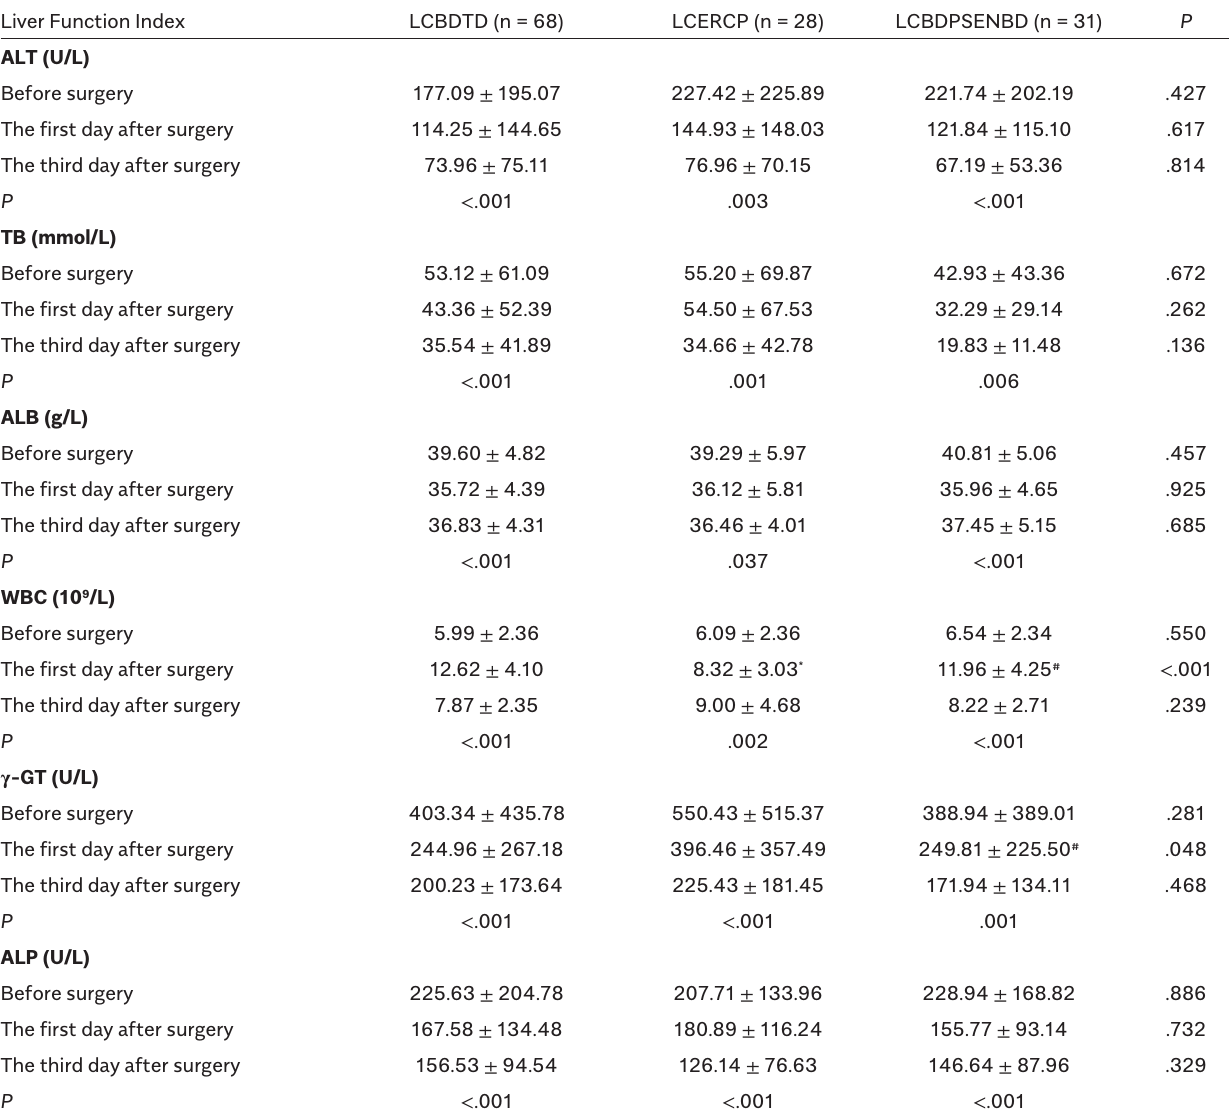
Table 4. Changes in Laboratory Indicators Before and After Different Surgeries Liver Function